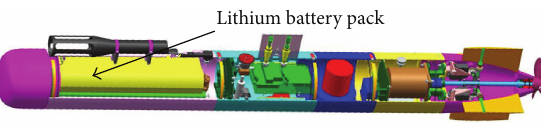
Figure 5: Certain structural layout AUV.